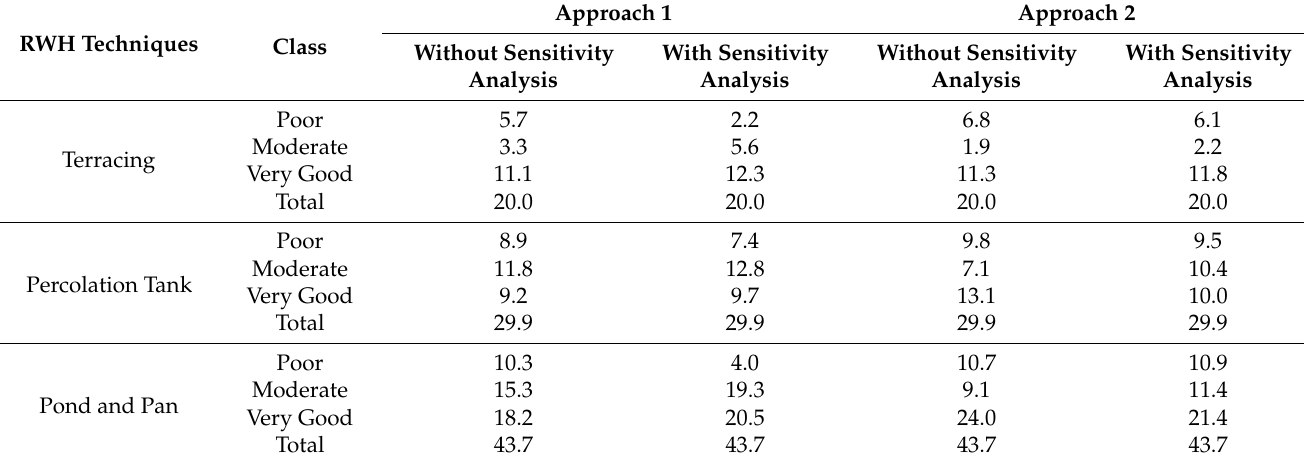
Table 7. The total potential area of the various RWH techniques in the study area as percentages. Approach 1 Approach 2 RWH Techniques Class Without Sensitivity With Sensitivity Without Sensitivity With Sensitivity Analysis Analysis Analysis Analysis